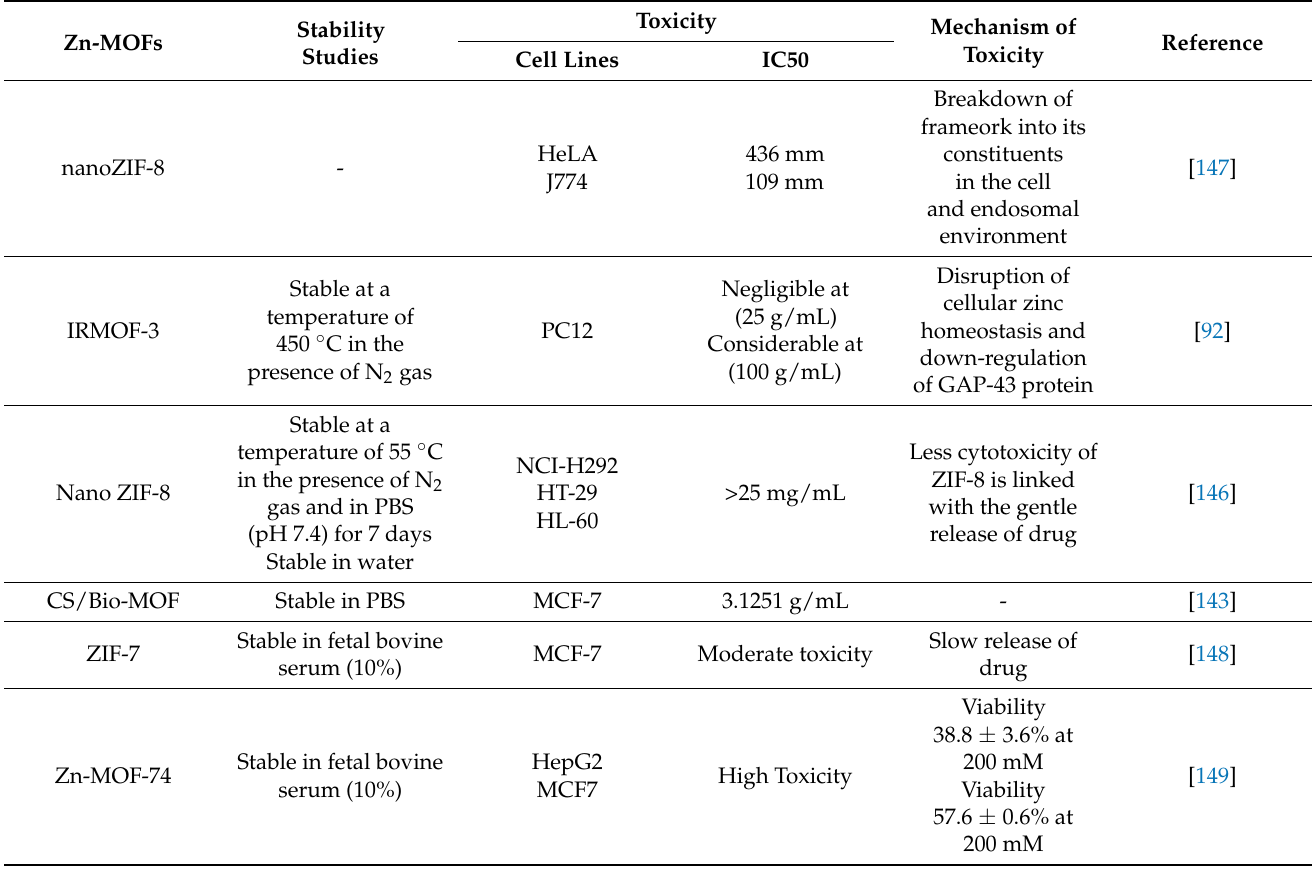
Table 2. Stability and toxicity associated with various Zn-based metal organic